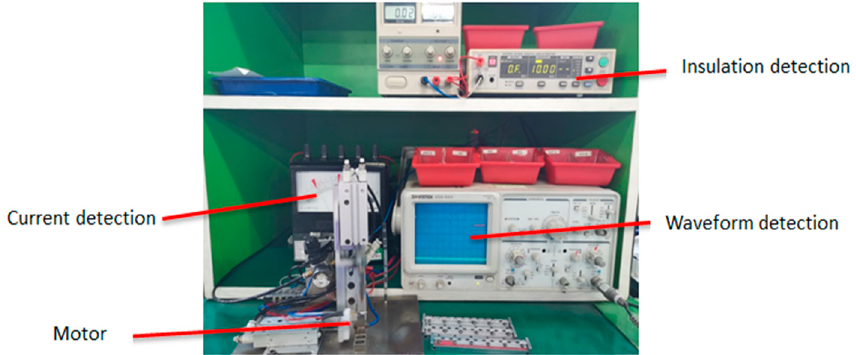
Figure 1. A motor waveform detection station.